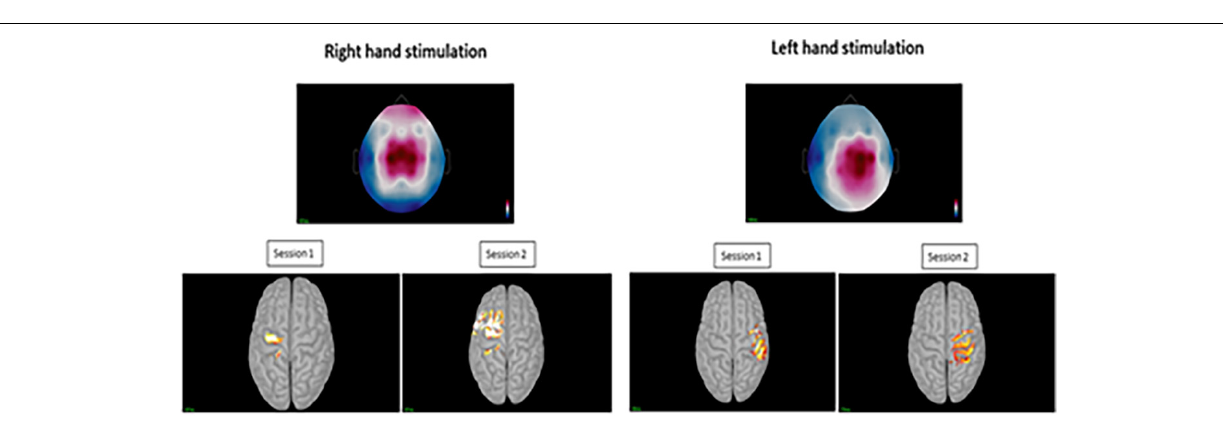
FIGURE 5 | Top images displaying the topography at sensor level during the positive peak activity of the pin-prick evoked potential for the right and left hand. Bottom figures displaying the averaged peak activity at the precentral and postcentral gyri for sessions 1 and 2 at both